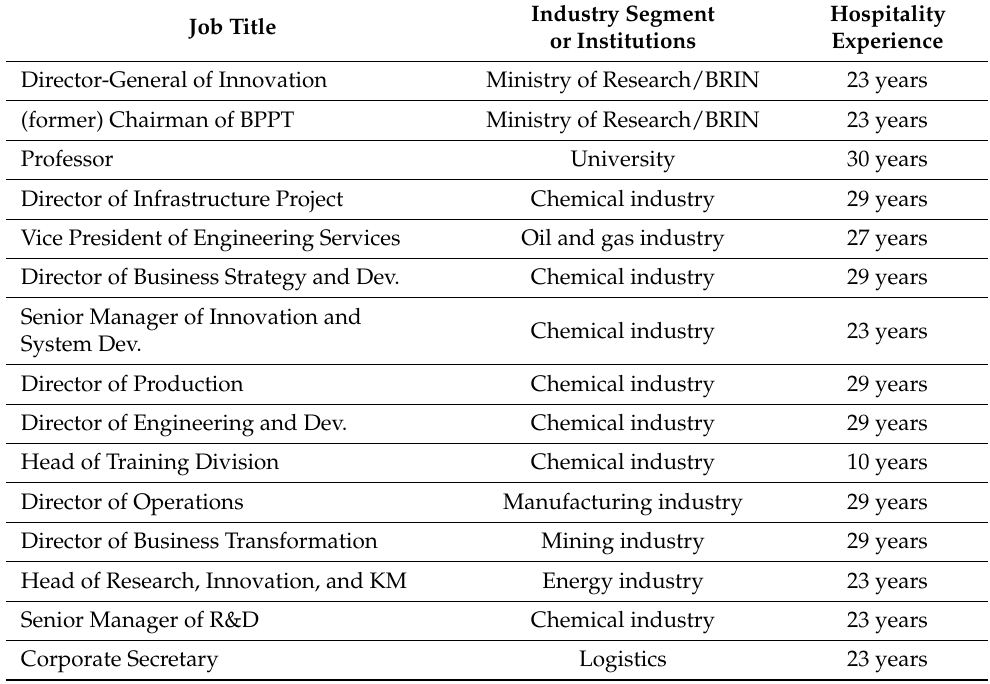
Table 2. Profile of